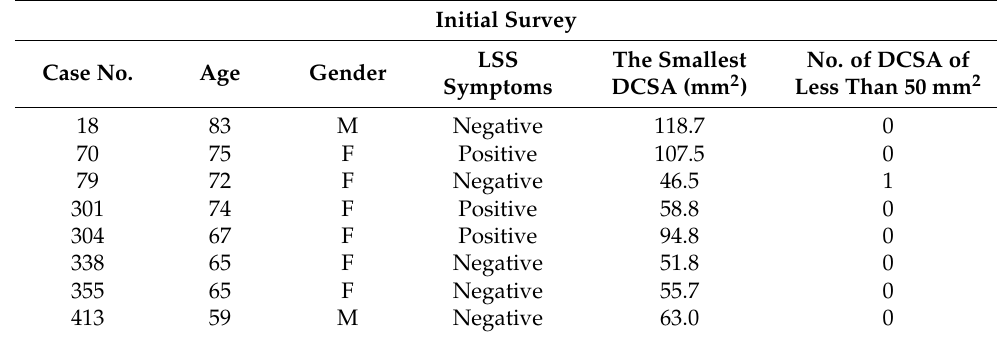
Table 6. Eight cases of surgery during the six-year